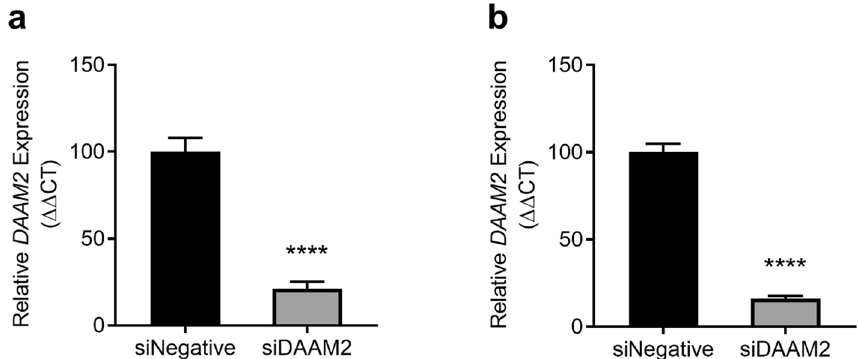
Figure 5. Knockdown of DAAM2 under normoxic (8% O 2 ) and hypoxic (1% O 2 ) conditions. Cytotrophoblast expression of DAAM2 mRNA was significantly knocked down under both normoxic (A) and hypoxic conditions with siRNA against DAAM2 (siDAAM2) compared to the negative control siRNA (siNegative). Data presented as fold change from control ± SEM. ****p < 0.0001. n = 3 experimental replicates (each sample from a different patient), with each experiment performed in